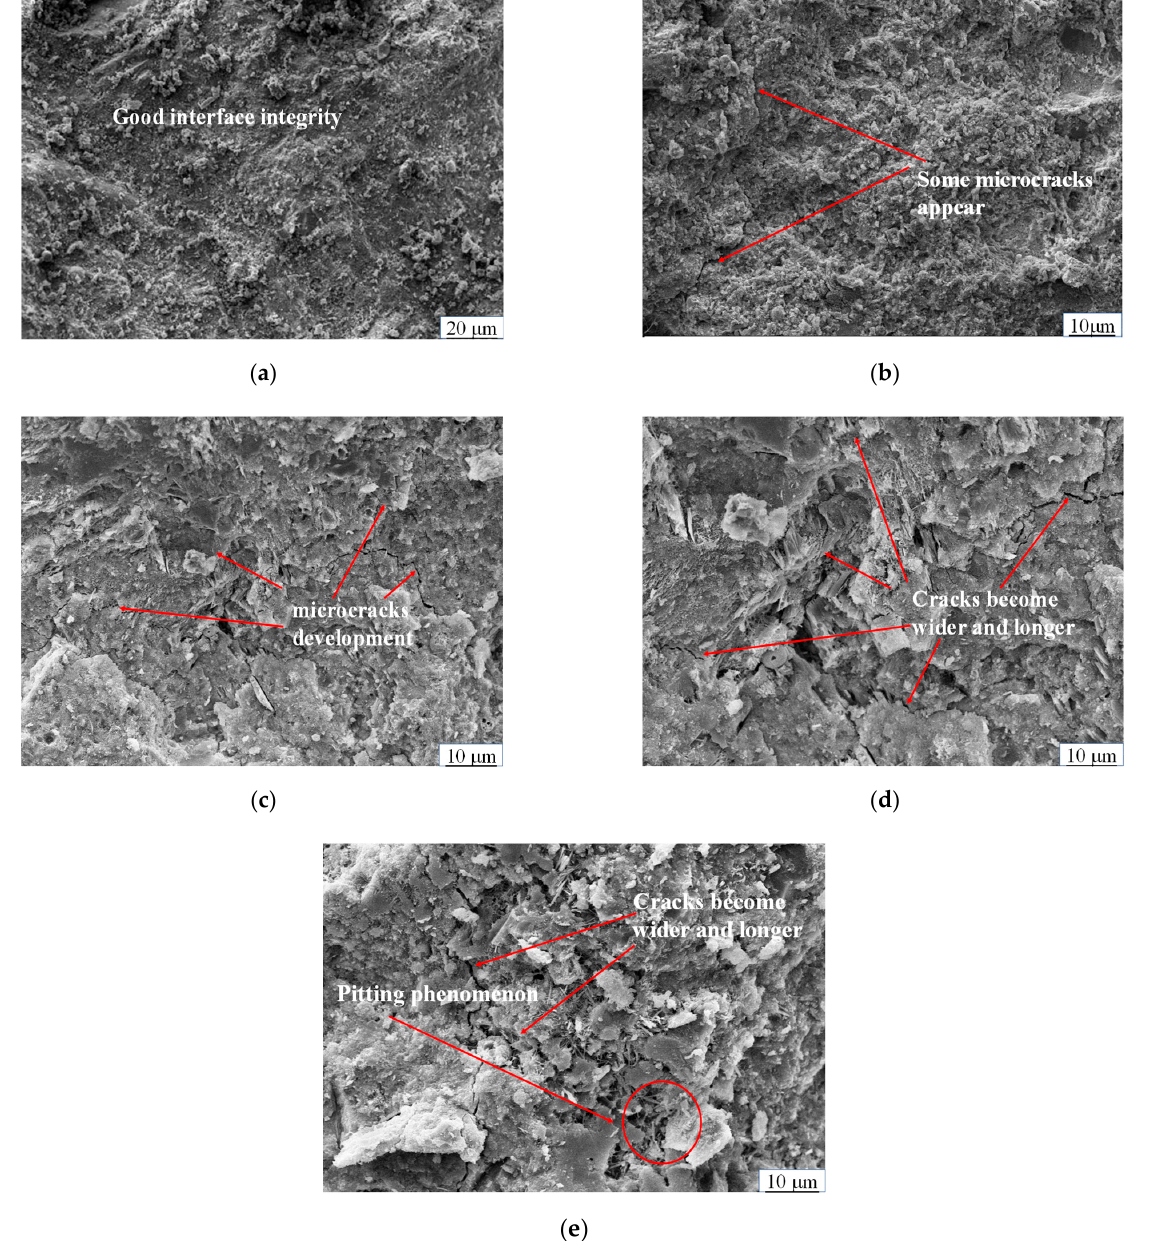
Figure 5. SEM images of CFRBCA3 at different freeze-thaw cycles: ( a ) 0 freeze-thaw cycles, ( b ) 10 freeze-thaw cycles, ( c ) 20 freeze-thaw cycles, ( d ) 30 freeze-thaw cycles, ( e ) 40 freeze-thaw cycles.